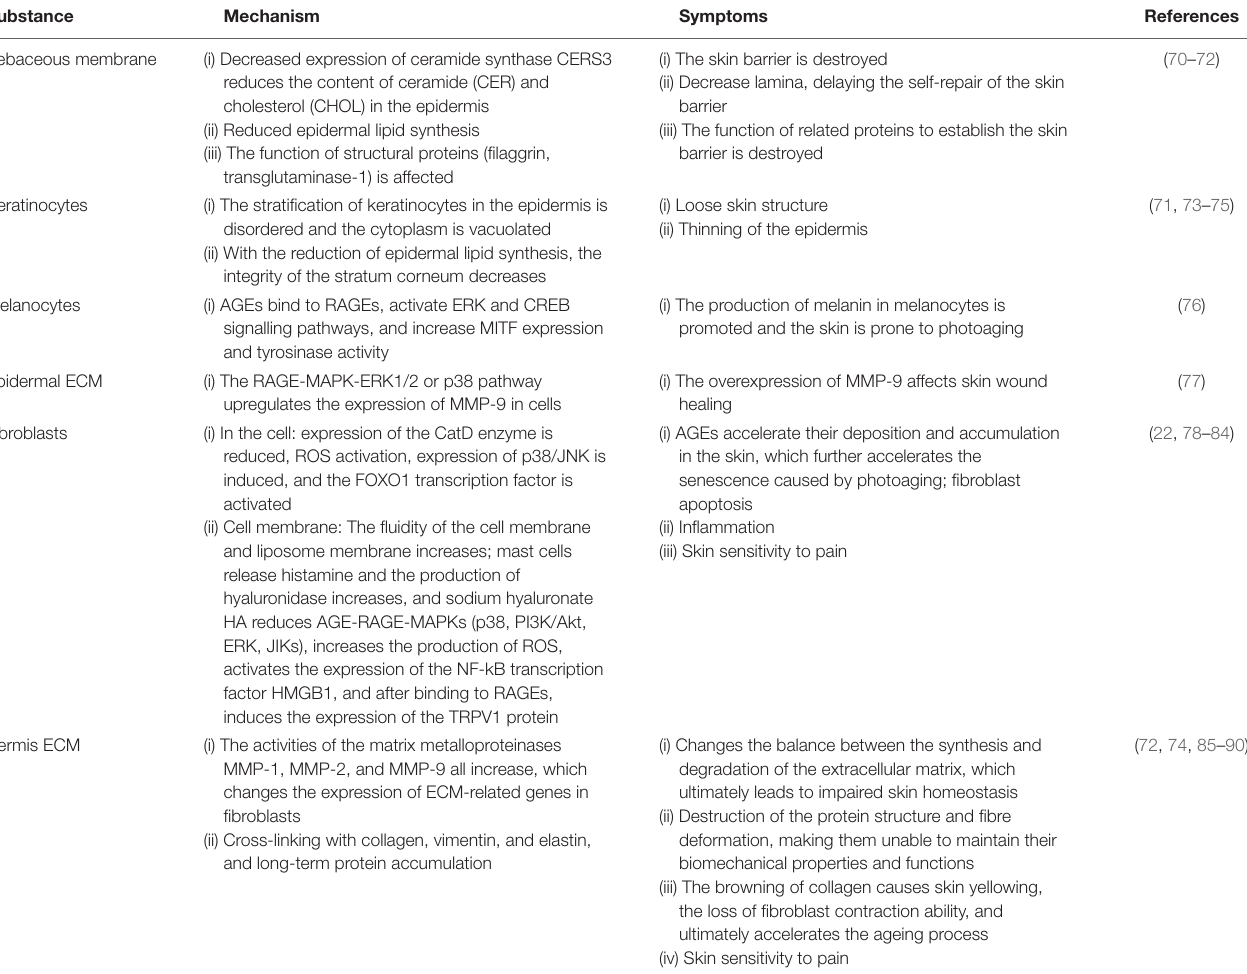
TABLE 1 | The effects of advanced glycation end products (AGEs) on various layers of the skin and their molecular mechanisms.